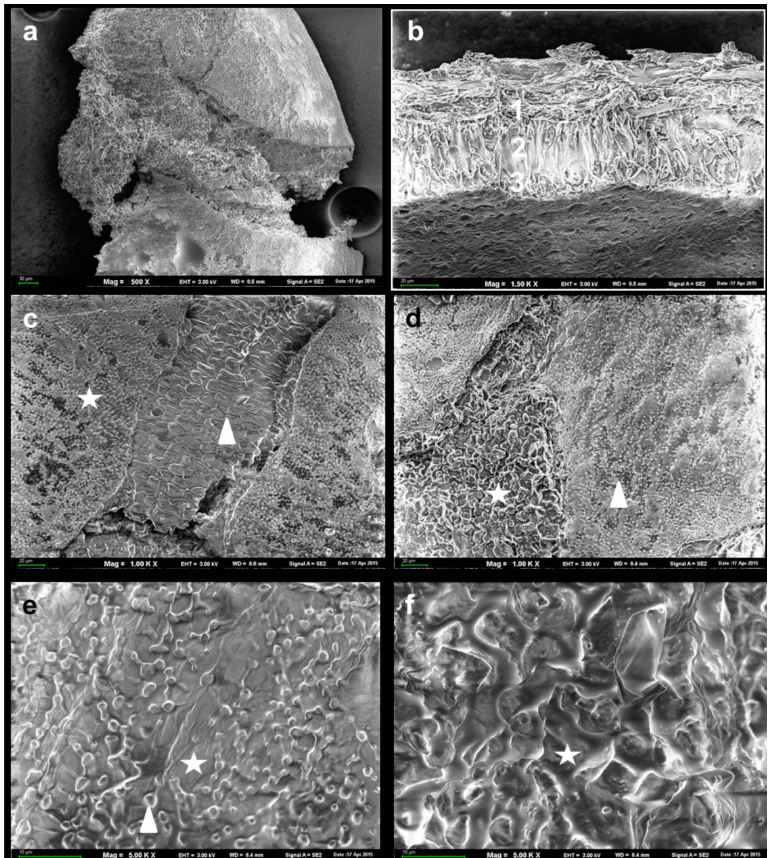
Fig. 2: Picture from scanning electron microscope (SEM). Structure of the lemon balm seed, strain (28/2013). (A) The seed with the damaged testa 30 μm. (B) Longitudinal section of the seed coat, 1 - crushed sclerenchymatous cells surface, 2 - subsurface cells sclerenchymatous cells arranged anticlinal to other layers 3 - sclerenchymatous cells arranged subepidermal side 20 μm. (C) Part of embryo tissue (arrow) and endosperm layers below testa (asterisk), 20 μm. (D) A different structure of the endosperm of the seeds lemon balm, aleurone layer of grain (arrow) and amorphous protein (asterisk), 20 μm. (E) Endosperm layers in the mature seed: aleurone grains (arrow) amorphous protein (asterisk) 10 μm. (F) The endosperm in the form of an amorphous protein under the surface of the seed, of 10 μm